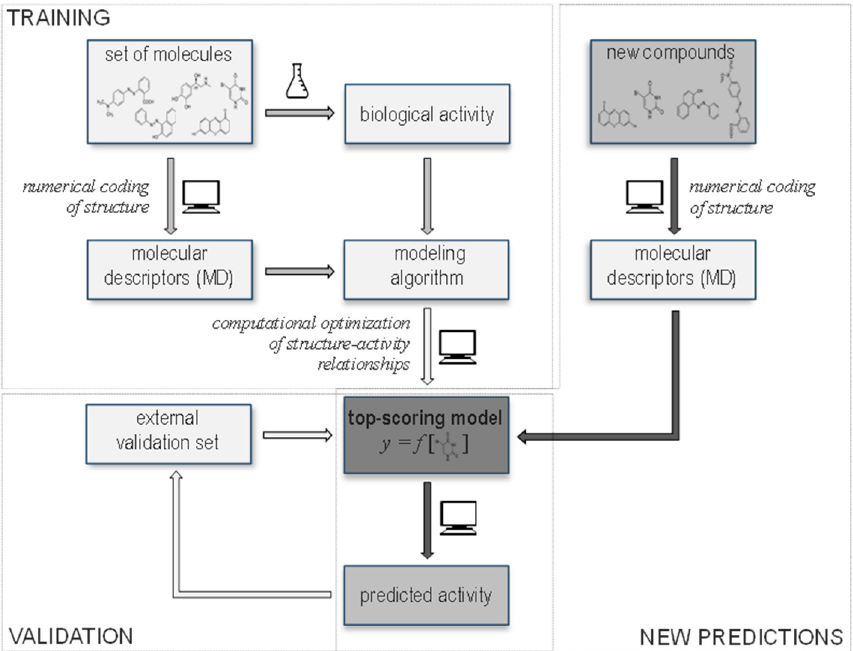
Figure 1. General scheme of the quantitative structure-activity relationship (QSAR) strategy. Chemical structures and biological activity data are obligated input for model building and validation. After the model development and optimization the new activity predictions can be made based solely on chemical structure input.